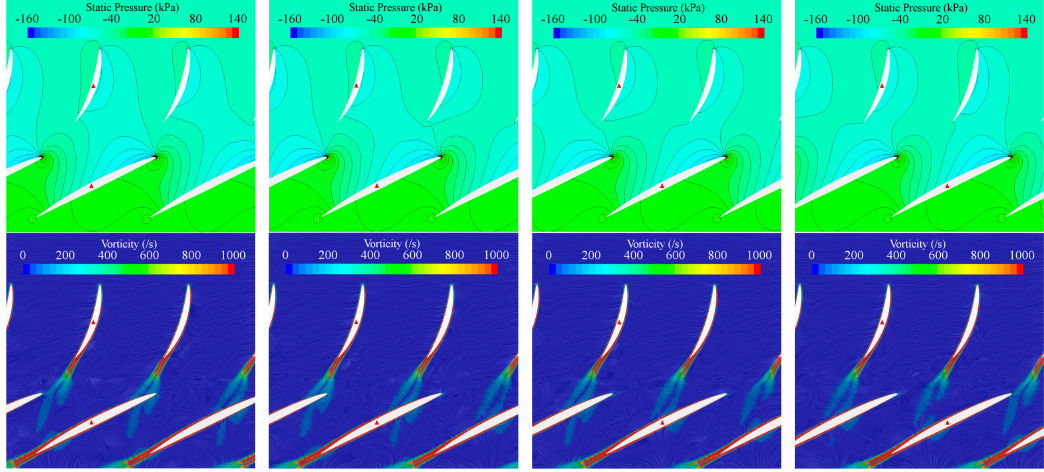
Figure 15. The pressure ( top row ) and vorticity ( bottom row ) around stator and rotor blade sections at